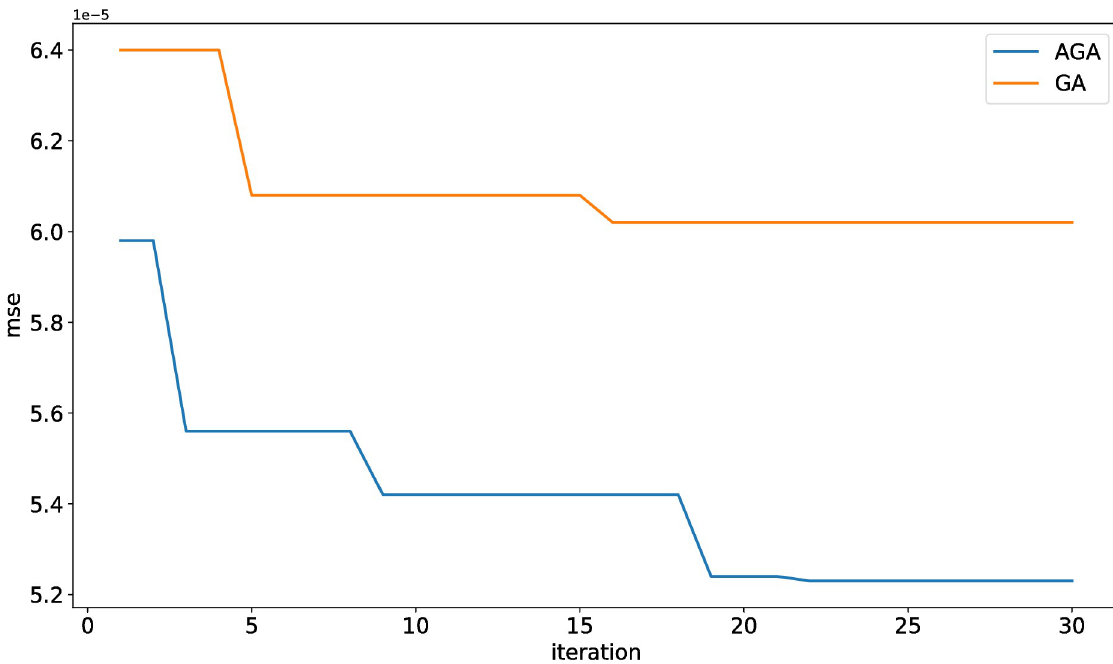
Fig 10. Fitness curve of AGA-LSTM and